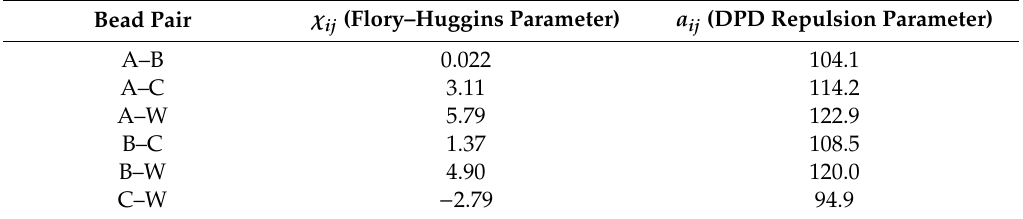
Table 1. Flory–Huggins interaction parameter and dissipative particle dynamics (DPD) repulsion parameter for di ff erent bead